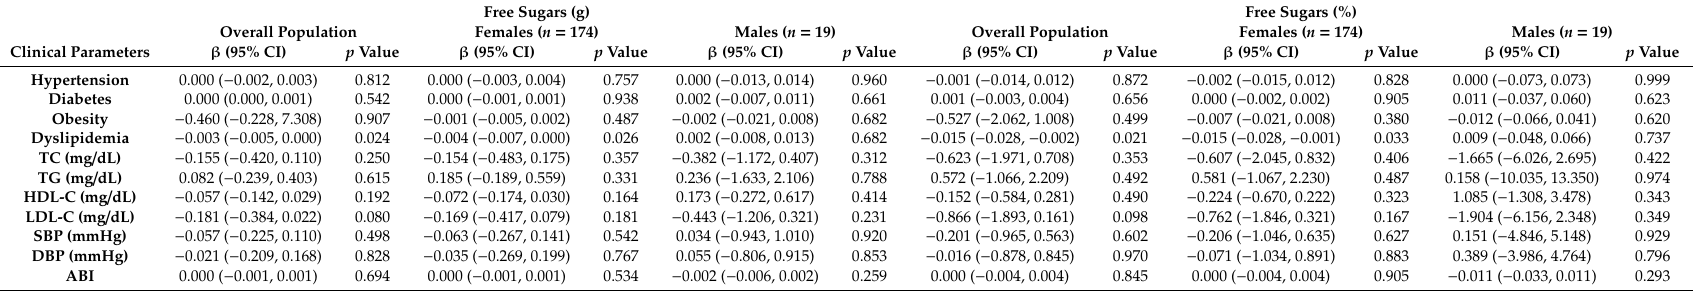
Table 4. Beta estimates and confidence intervals for the association between free sugars intake and cardiovascular risk factors in SLE